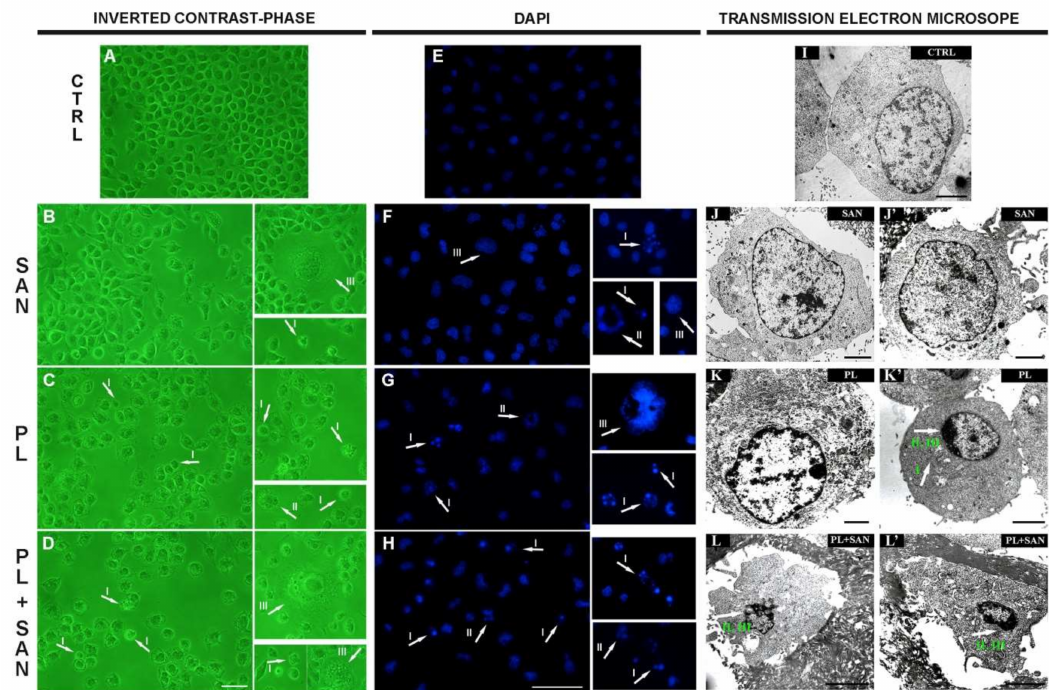
Figure 6. The e ff ects of piperlongumine (PL) and sanguinarine (SAN) individually and in a combined treatment on the morphology, cell nuclei and ultrastructure of A549 cells. In the pictures ( A – H ), arrows indicate observed changes: contracted nuclei with a visible condensation of chromatin, apoptotic bodies (phenotype of apoptosis— I ) and cells with features typical for mitotic catastrophe (multinucleated— II and giant cells— III ). Bar—50 µ m. In the pictures ( I – L , L (cid:48) ), arrows mark visible changes: enlarged mitochondria ( I ), shrunken cell nucleus ( II ) and the condensation of chromatin ( III ). Bar—5 µ